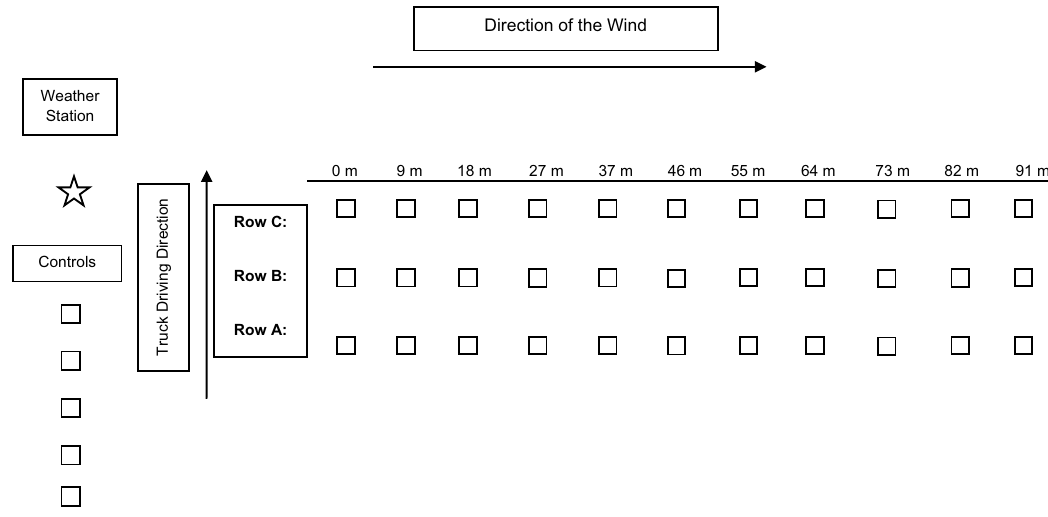
Fig. 1 Map of the droplet characterization grid, including weather station, the locations of the control sampling stations (n=5), the location of the rows (n=3), bioassay jars at different distances from the spray path (0-91m), Sunny Shores, Cortez, Florida,